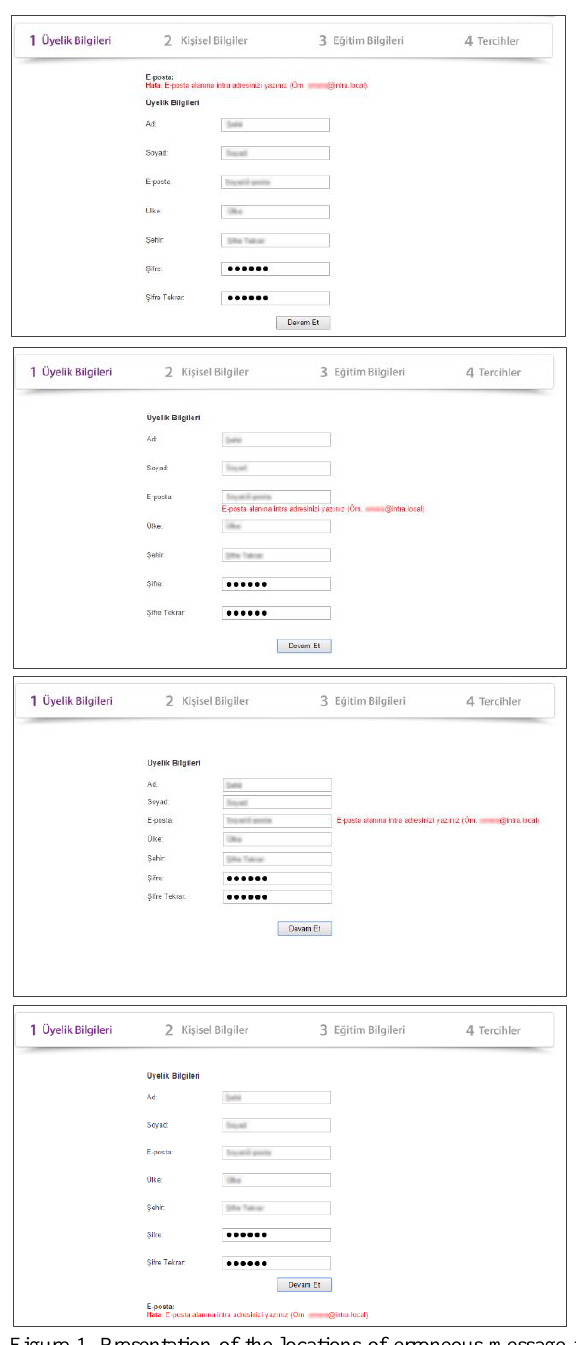
Figure 1. Presentation of the locations of erroneous message in four participant